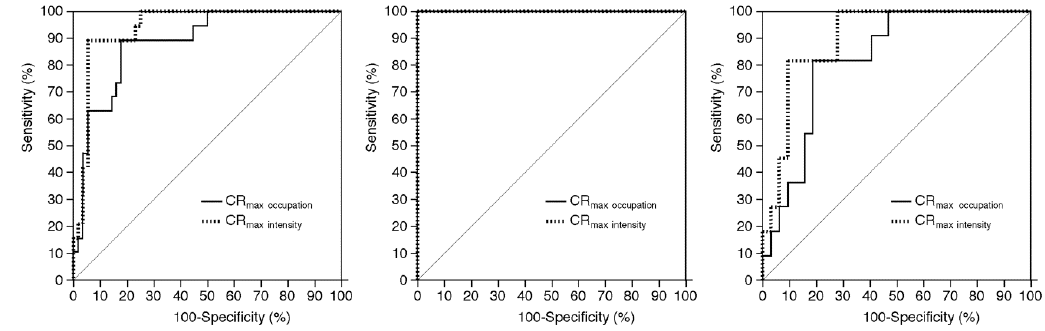
Figure 2. Receiving operator characteristic (ROC) curves used to compare predictive accuracy between CR max occupation and CR max intensity for the development of MES during exposure of the carotid arteries ( left , for all patients; middle , for patients with identification of the image with the POR max occupation and that with the maximum plaque intensity; right , for patients without this identification). In the middle panel, each area under the ROC curve for CR max occupation or CR max intensity (each CR max occupation is identical to CR max intensity , respectively) is 1.000.